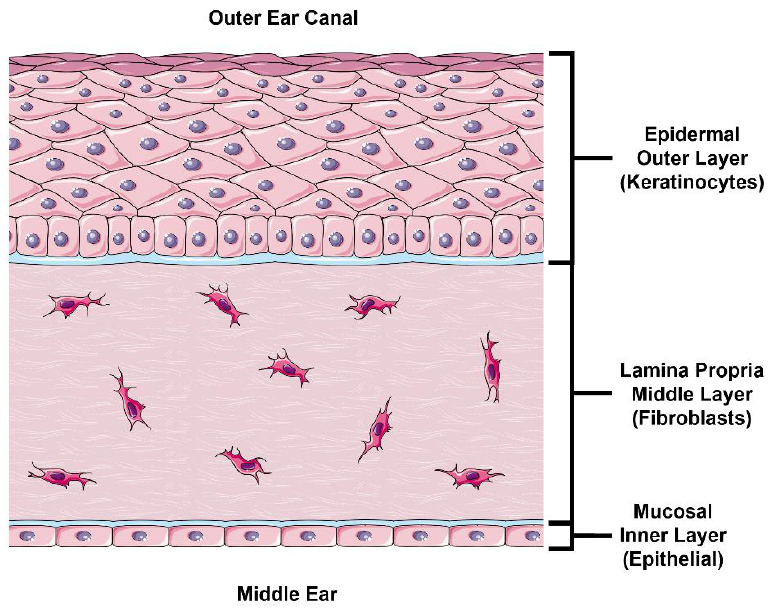
Figure 1. Illustration of TM Cross Section. The outer layer of the TM consists of a stratified epidermis skin layer consisting primarily of keratinocytes. The lamina propria (middle layer) consists of fibroblasts embedded in connective tissue (primarily collagen and elastin). The inner (middle ear) layer of the TM consists of a thin mucosal epithelial layer. TM, tympanic membrane. This figure was drawn using modified artwork from Servier Medical Art. Servier Medical Art by Servier is licensed under